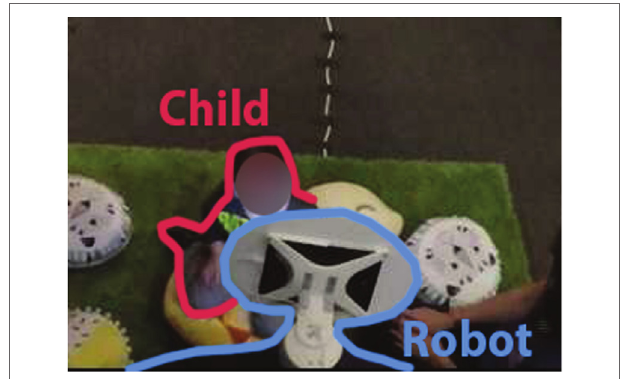
FigUre 8 | Extraction of the children’s location from the camera view. The location of the children was determined by identifying the point at the middle of their forehead.